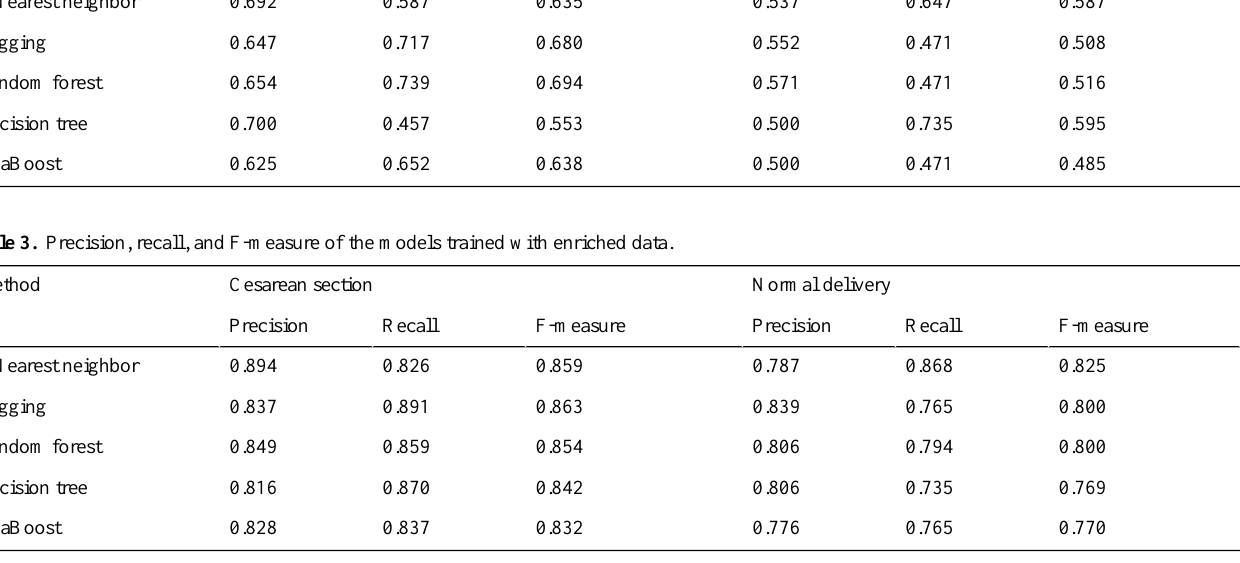
Normal deliveryCesarean sectionMethod